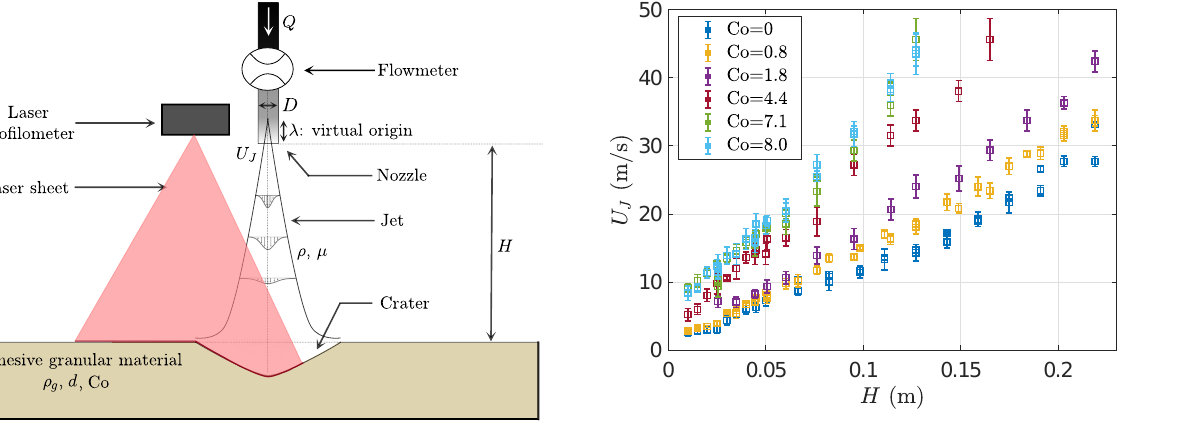
Figure 1. Schematic of the experimental setup. A jet exiting the nozzle of diameter d at the mean velocity U J impacts the granular bed placed at a distance H .